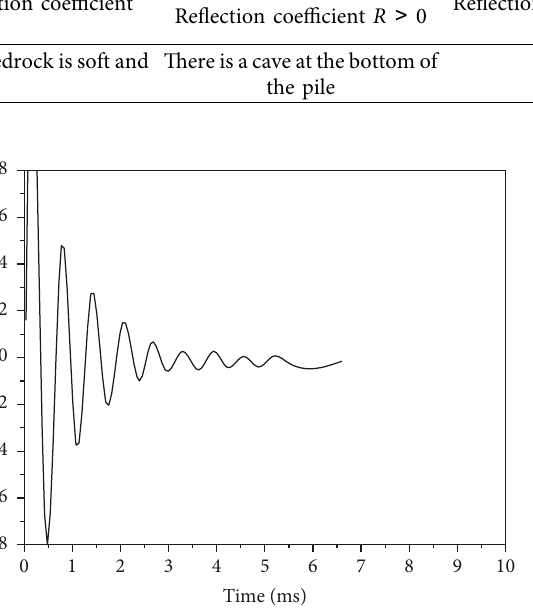
Figure 1: The ideal reflected signal when the pile bottom is complete.